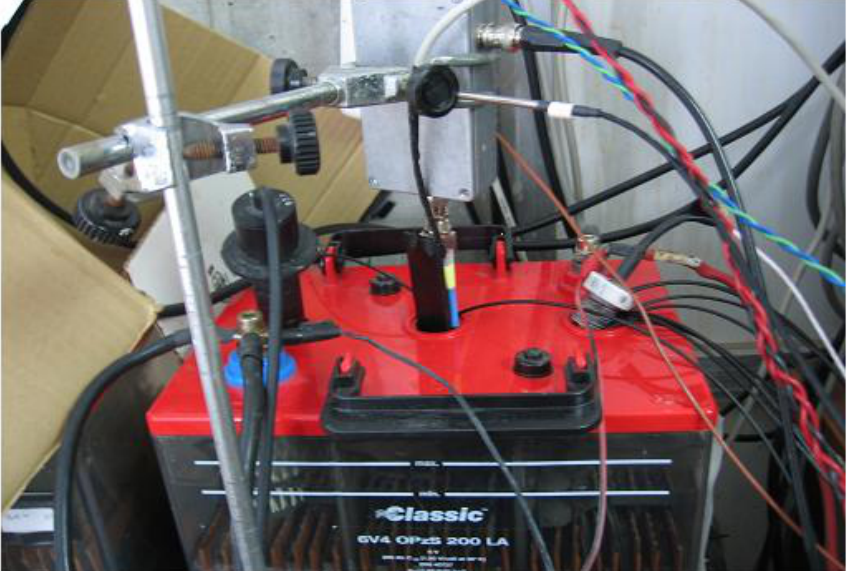
Figure 5. QCM sensor placed inside the battery during real time